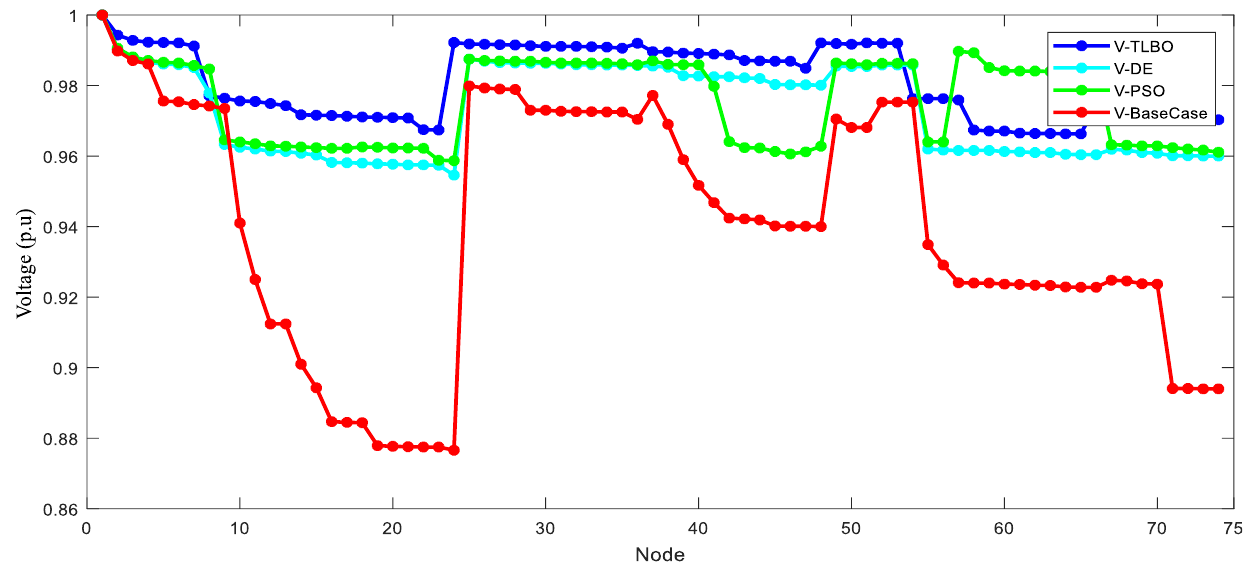
Figure 4. Restored network in single fault cases without protection constraints using TLBO.